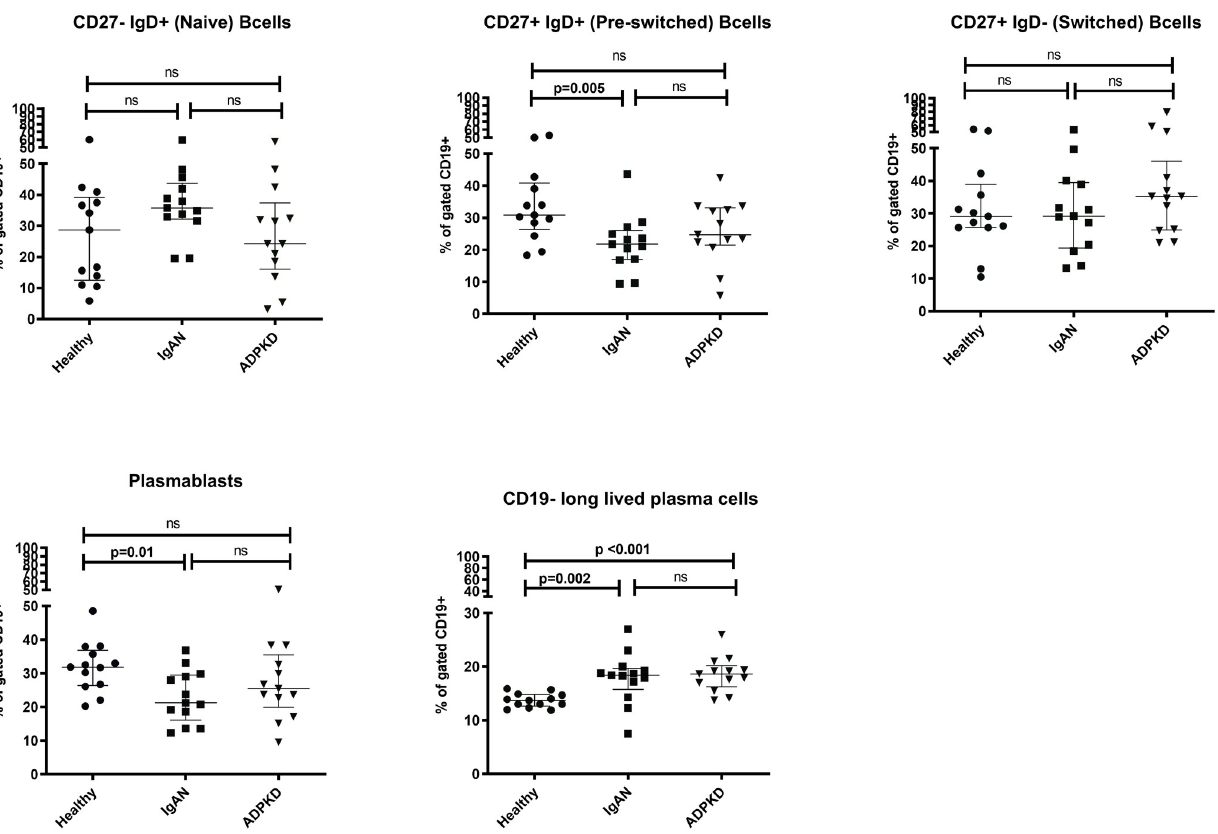
Fig 2. Proportions of B cell subsets. Proportions of B cell subsets in patients with IgA nephropathy (IgAN), autosomal dominant polycystic kidney disease (ADPKD) and in healthy controls (HC). Comparisons for cell fractions were performed using the Kruskal-Wallis test, P < 0.05 was considered statistically significant. Scatter plots represent the range with whiskers and the median as the middle